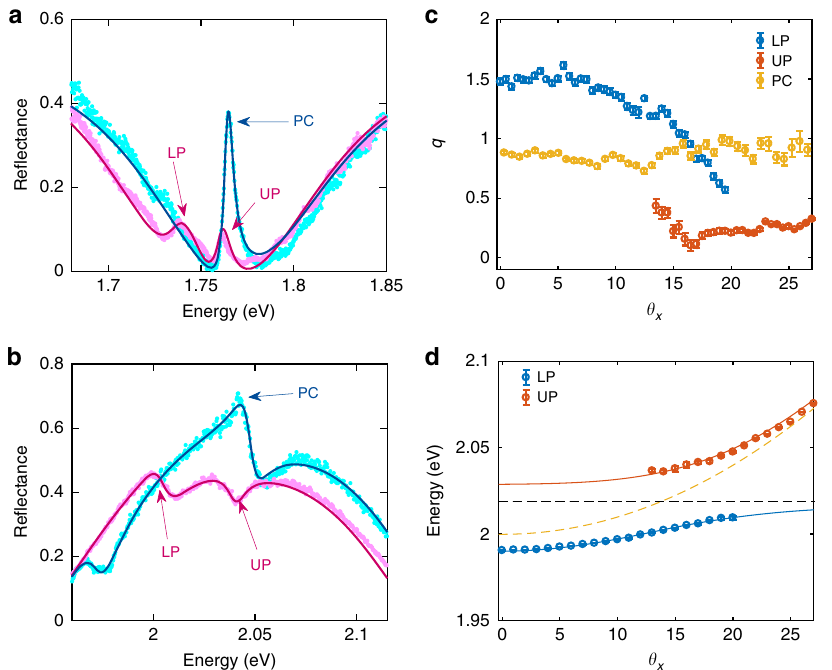
Fig. 5 Fano resonance in the re fl ectance of the a WSe 2 and b WS 2 systems, measured at θ x = 24° and 17.5°, respectively. Blue dots are the re fl ectance spectra of the bare PCs, and red dots, the TMD-PC devices. The lines are comparison with Fano line shape given by Eq. (4). The asymmetry parameter q for PC, LP, and UP in WSe 2 system is 5.0, 3.5, and 4.1 respectively, and in WS 2 system, is 0.93, 0.83, and 0.18. c The fi tted asymmetry parameter q as a function of angle from the re fl ection of WS 2 bare PC (yellow circles) and WS 2 -PC device (blue and red circles). d Extracted lower and upper polariton energies as a function of angle, as indicated by red and blue circles, respectively. Red and blue solid lines are the fi ttings. Yellow and black dashed lines represent the cavity and exciton dispersion. All the data points are extracted by fi tting the re fl ection spectrum in the left panel of Fig. 4b using Eq. (4), and the error bars are extracted by least square data fi